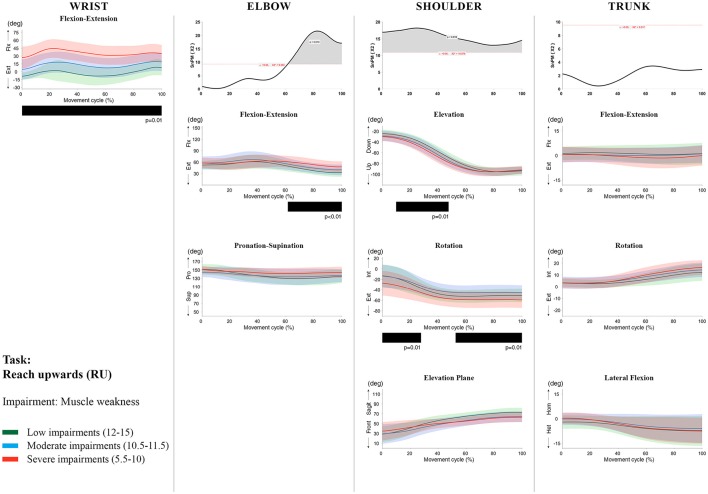
Impact of muscle weakness on UL movement patterns in children with uCP during the RU task for all joint angles. Each column corresponds to a joint (from left to right: wrist, elbow, shoulder, and trunk). The top image of each column is the SPM output of the vector field analysis (non-parametric Canonical Correlation Analysis test, except for the wrist, where a non-parametric linear regression was computed). For visualization purposes, kinematic data was grouped according to the level of motor impairments, i.e., muscle weakness total score: low impairments (score between 12 and 15, i.e., values above percentile 75), moderate impairments (score between 10.5 and 11.5, i.e., values between percentile 25 and 75), and severe impairments (score between 5.5 and 10, i.e., values below percentile 25). Below, mean (bold line) and standard deviation (translucent area) of the low impairments (green), moderate impairments (blue), and severe impairments (red) of each vector component and the respective post-hoc SPM{t} output. The black bar under each kinematic profile indicates clusters of significant influence of the impairment level on the kinematic variable.